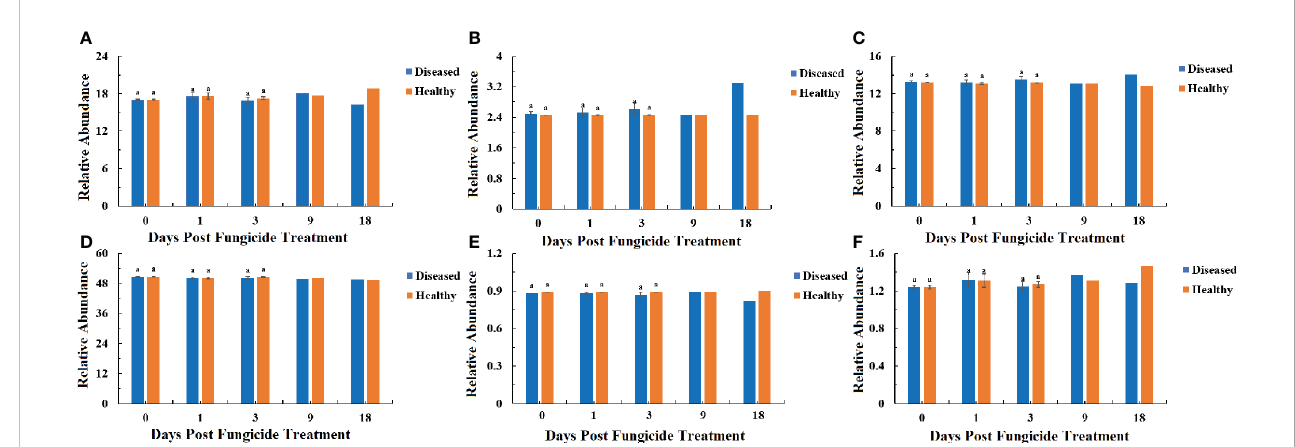
FIGURE 8 PICRUSt analyses of the changes in the KEGG level 1 functional categories of bacteria in tobacco leaf samples. (A) Genetic Information Processing, (B) Cellular Processes, (C) Environmental Information Processing, (D) Metabolism, (E) Organismal Systems, (F) Human Diseases. Statistical analysis was not performed for results of diseased samples at 9 and 18 dpt as there was only one replication.